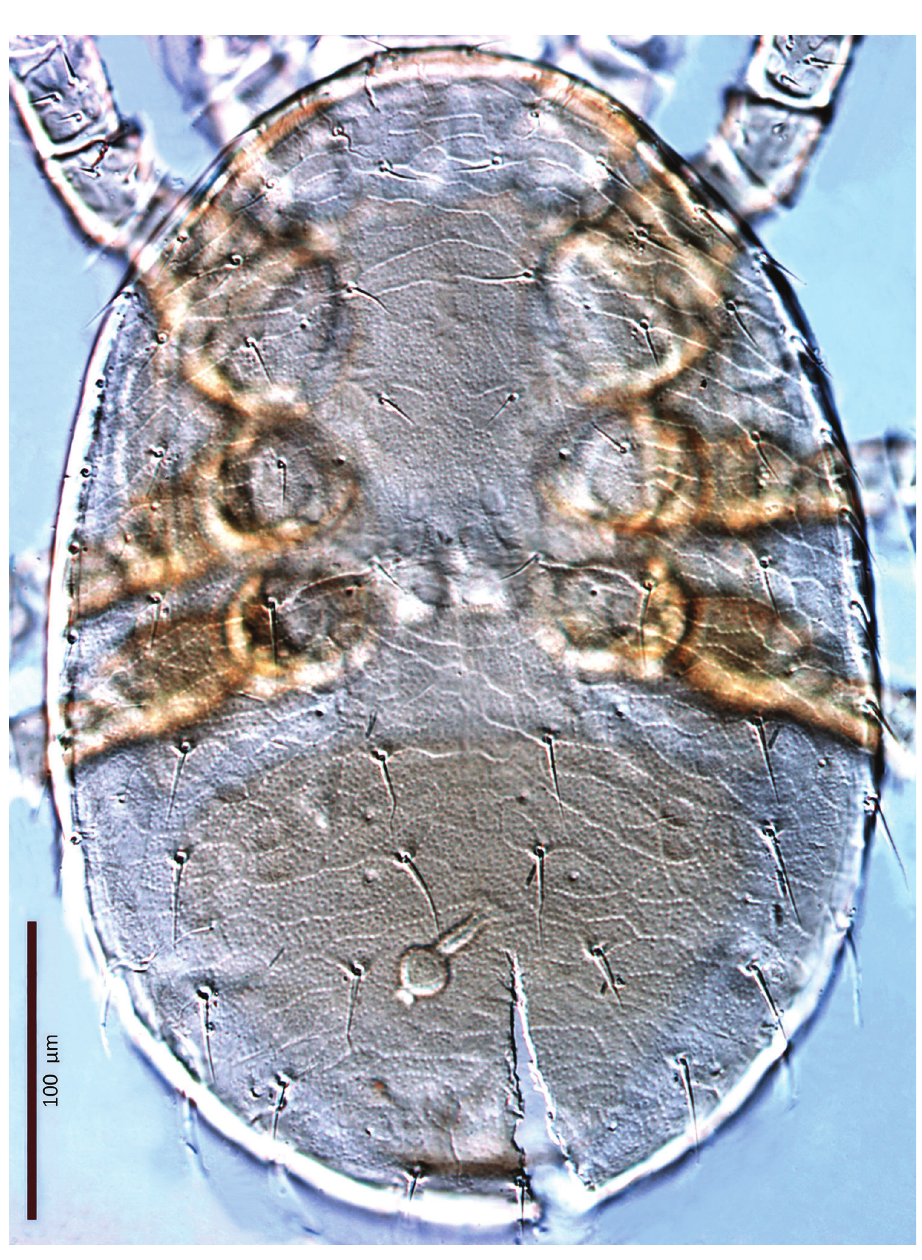
Figure 32. Zygoseius lindquisti sp. n., female, dorsal idiosoma.